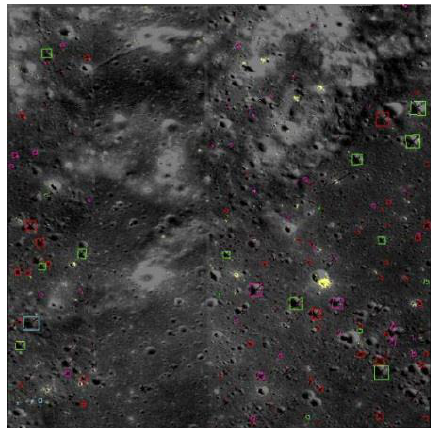
Figure 5. Extracting and "non iron" algorithm result By judging whether the extracted standard circle contains "non iron" region or not, the correctness of the impact crater could be judged. Table 3 is the confusion matrix of 505 extracted craters.